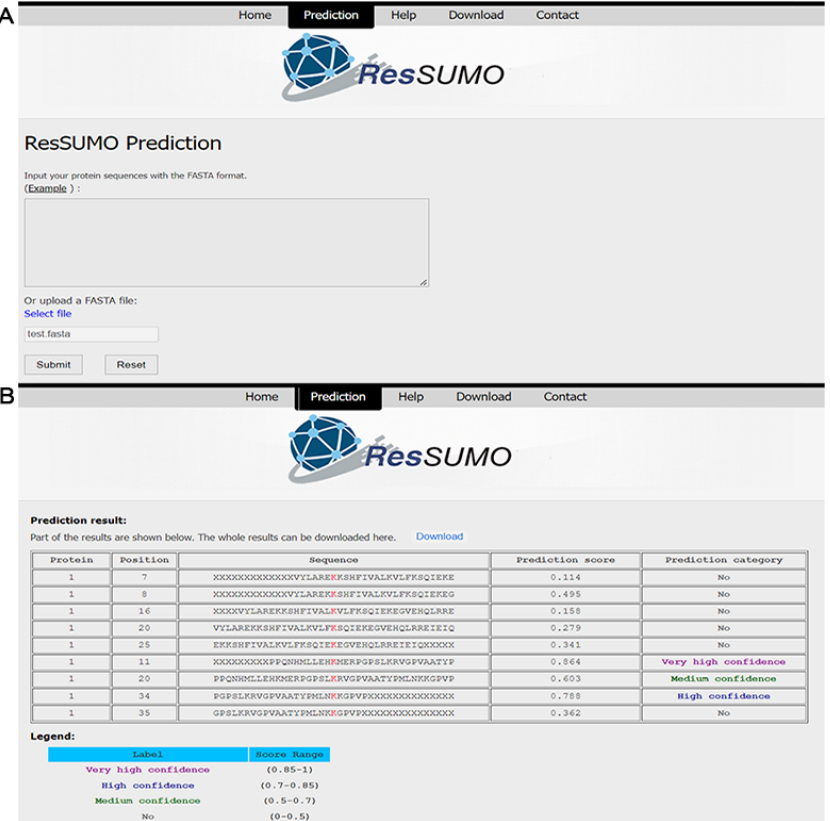
Figure 6. The online ResSUMO interface for the prediction of lysine SUMOylation sites ( A ) and its application in prediction ( B ).